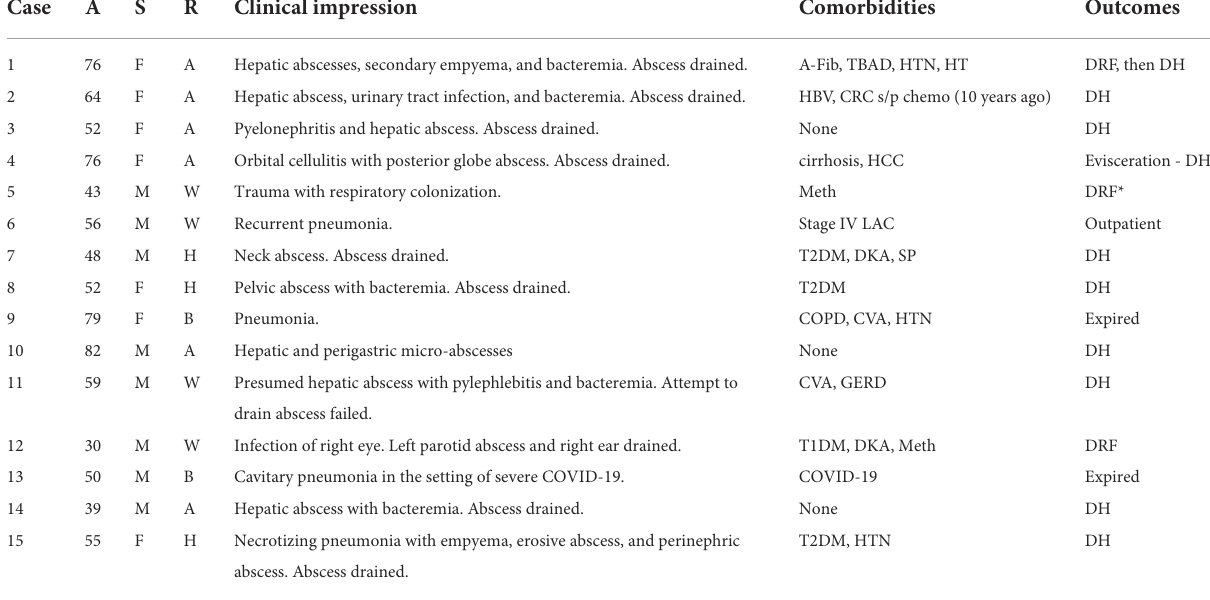
TABLE 1 Summary of hvKp